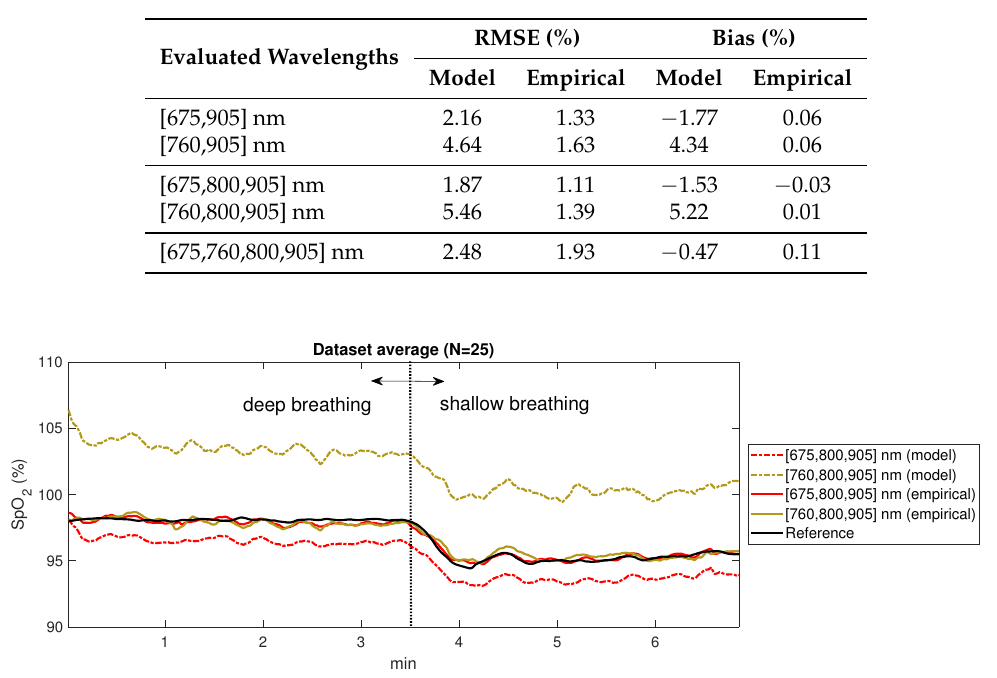
Table 1. The overall results for the model-based and empirical, data-driven APBV calibration model.